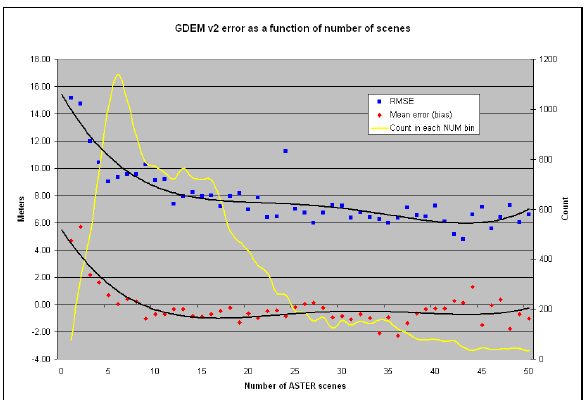
Figure 8. GDEM v2-NED and GDEM v2-SRTM mean differences by land cover